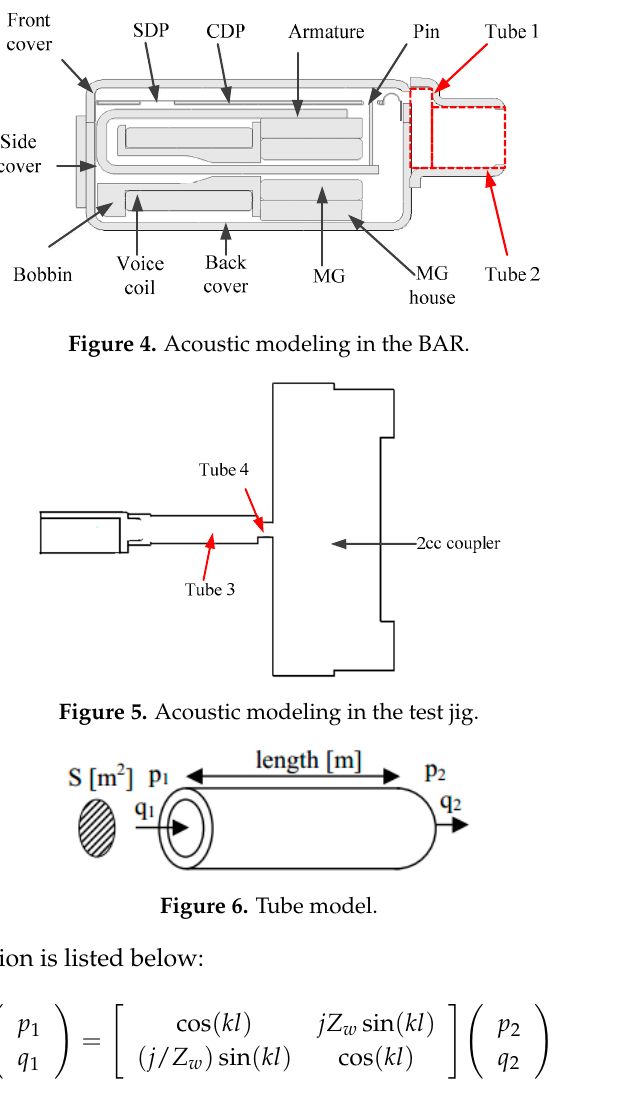
Figure 6. Equivalent circuit of cavity.